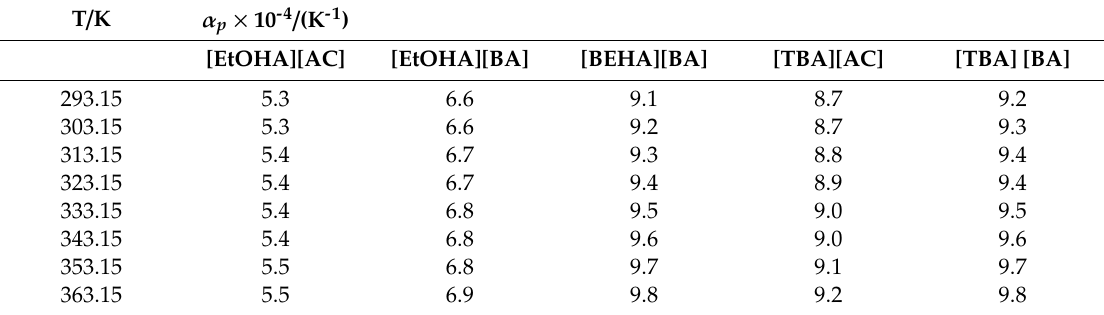
Table 6. Thermal expansion coe ffi cients ( α p ) of the ionic liquids calculated using Equation (6). T / K